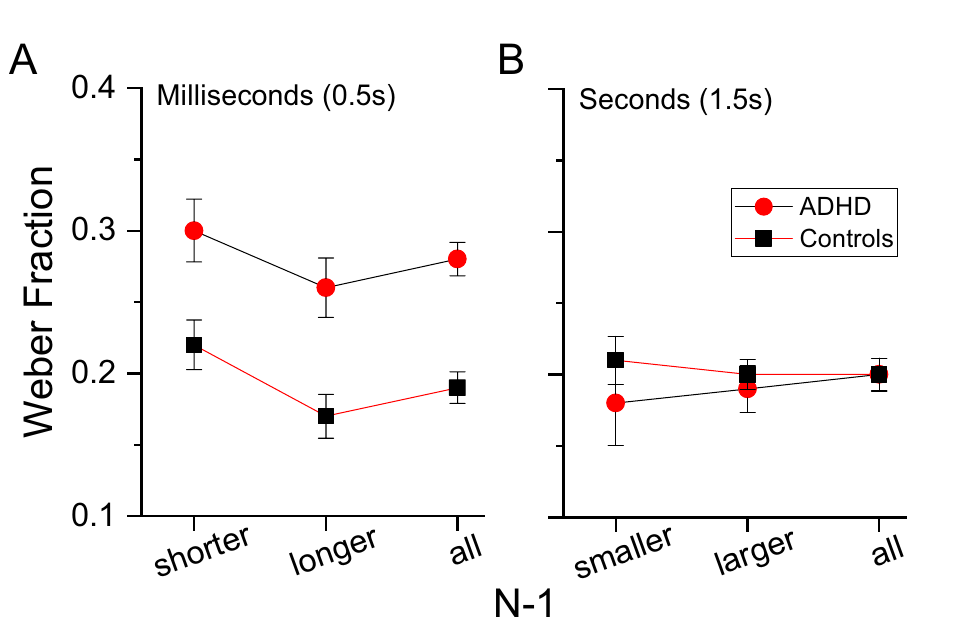
Figure 4. Auditory time thresholds for stimuli in the milliseconds ( A ) and seconds ( B ) ranges measured on all trials (all) or on data sorted as a function of the preceding stimulus duration (N-1) that could be shorter or longer compared to the stimulus judged in the current